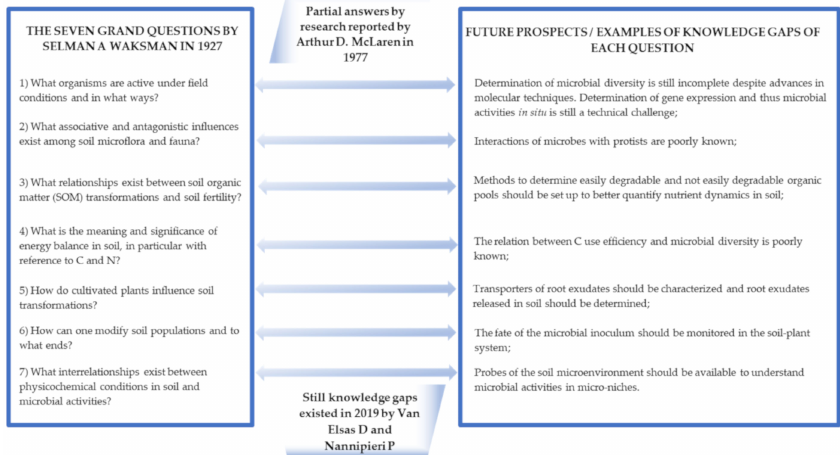
Figure 1. The seven grand questions by Selman A. Waksman and one knowledge gap for each question still present